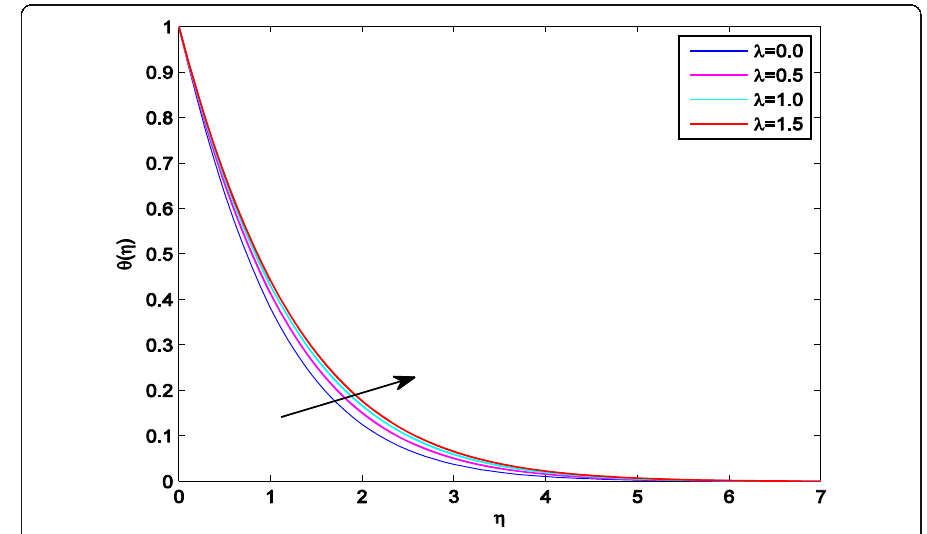
Fig. 22 Temperature graph for various values of